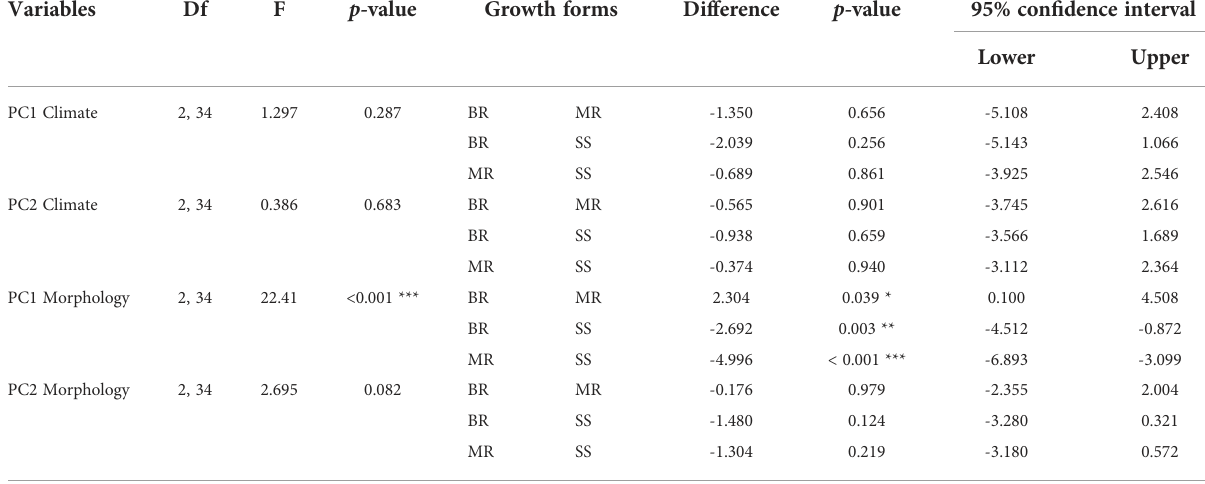
TABLE 1 Results of ANOVAs and Tukey HSD post-hoc testing for PC1 and PC2 axes of climate and morphology among growth forms.